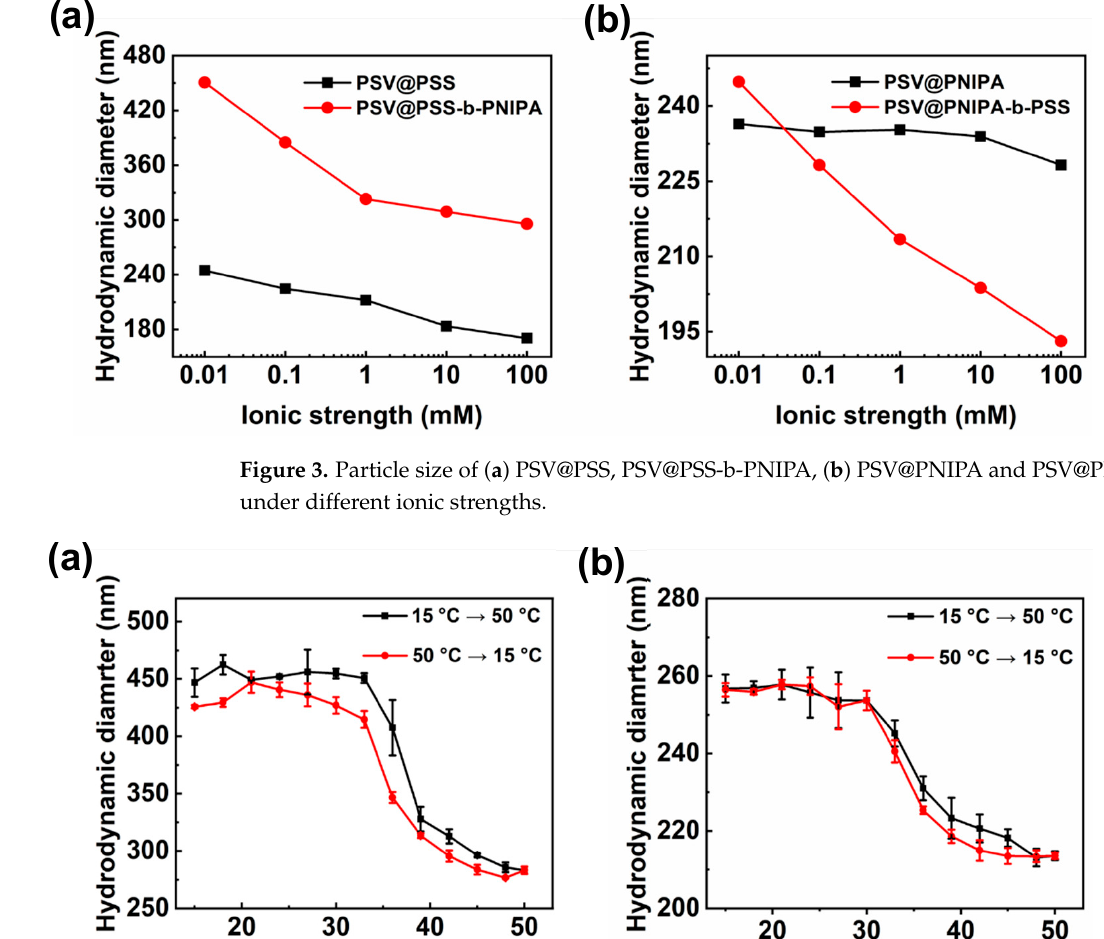
Figure 3. Particle size of ( a ) PSV@PSS, PSV@PSS-b-PNIPA, ( b ) PSV@PNIPA and PSV@PNIPA-b-PSS under different ionic strengths.